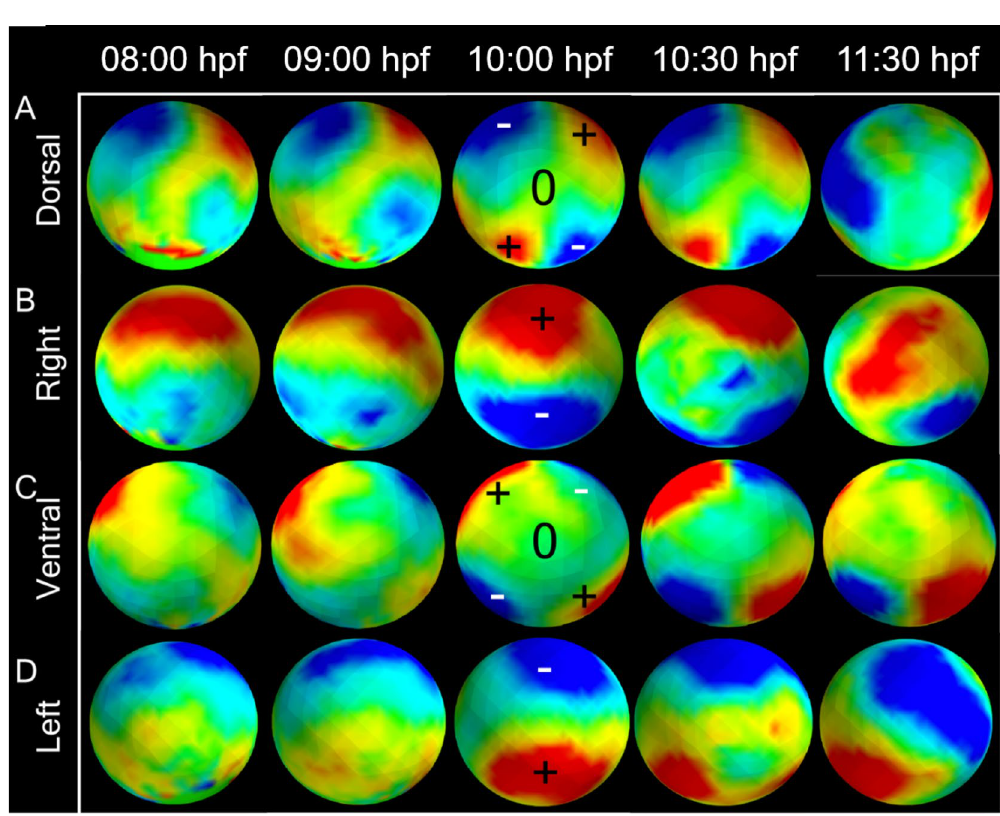
Figure 6. Positive (red) and negative (blue) rotational strain quantified by curl at 8 (80% epiboly), 9 (90% epiboly), 10 (bud, 100% epiboly), and 10.5 hpf (1-somite). In ( A ), ( B ), and ( C ), the embryo is oriented with anterior and posterior to the top and bottom. Positive curl is clockwise, negative curl is counter-clockwise. ( A ) Curl map of rotational strain over the dorsal view of the embryo. ( B ) Right side view of rotational strain of the embryo. (Dorsal is in the left side). ( C ) Curl map of rotational strain over the ventral view of the embryo. ( D ) Left side view of rotational strain of the embryo (dorsal is in the right